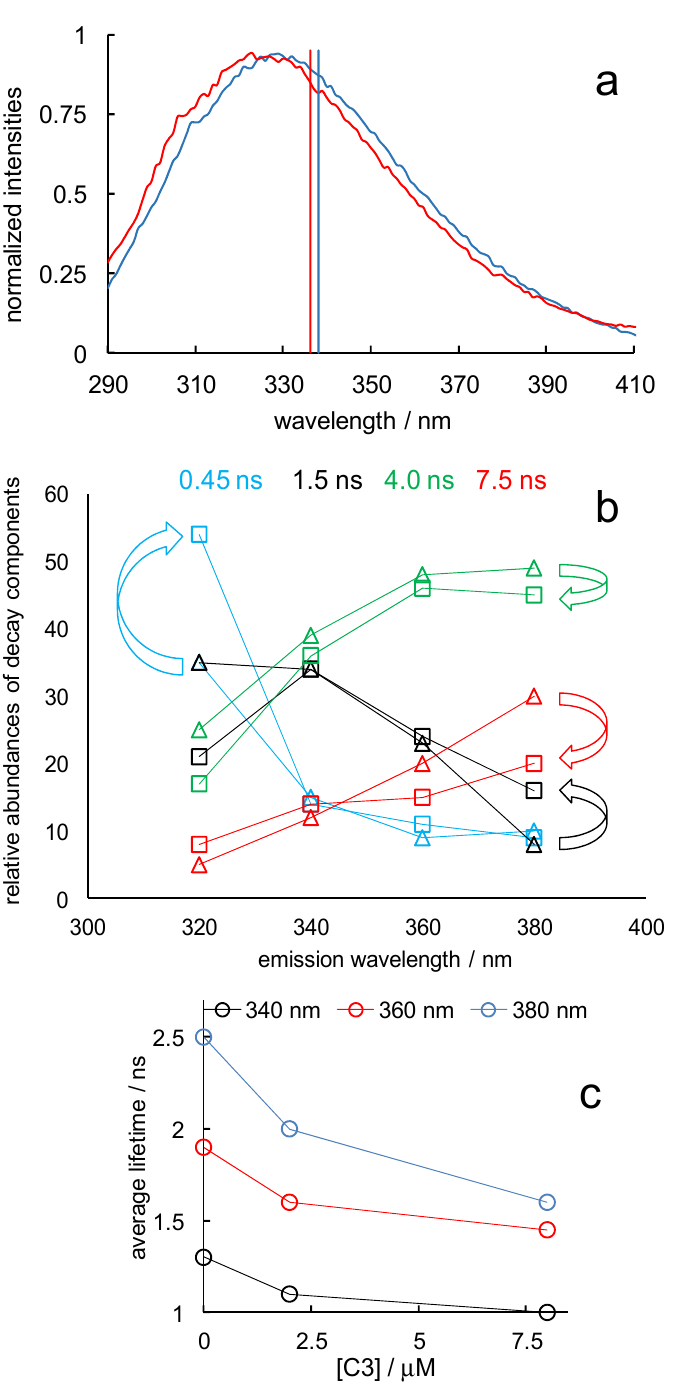
Figure 6. Effects of binding of compound C3 on Lm PTR1 fluorescence ( a ) Emission spectra without (blue curve) and with (red curve) 8 µ M C3 at λ exc = 280 nm. The spectra were normalized to their maxima; the vertical segments indicate the wavelengths of the corresponding band centroids. ( b ) Relative abundances of the four main components of the Lm PTR1 emission decay at four emission wavelengths without (triangles) and with (squares) 8 µ M C3. The curved arrows highlight the changes caused by ligand addition in the abundances of the 0.45 ns component at 320 nm and of the other three components at 380 nm. ( c ) Dependence of the amplitude-averaged lifetimes at three emission wavelengths on C3 concentration. λ exc = 285